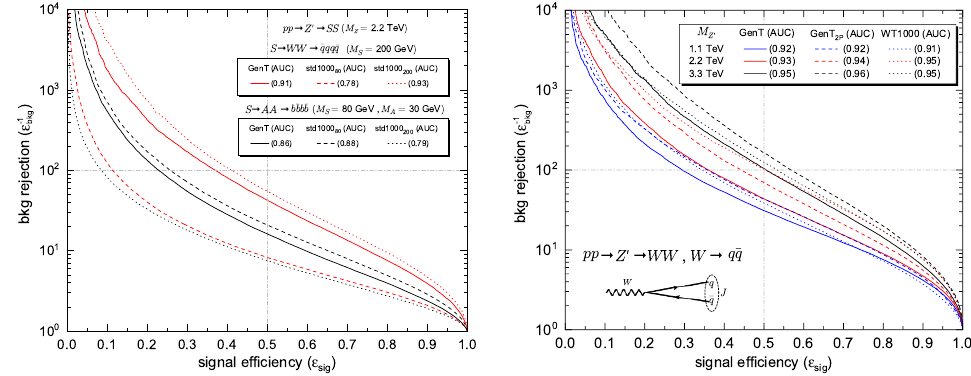
Figure 4 . Left: comparison of the performances of GenT and taggers pca1000 80 and pca1000 200 trained on narrow jet mass and p intervals, for two examples of four-pronged jet signals. Right: T comparison of the performances of GenT and GenT with a tagger WT1000 specifically designed for 2P W